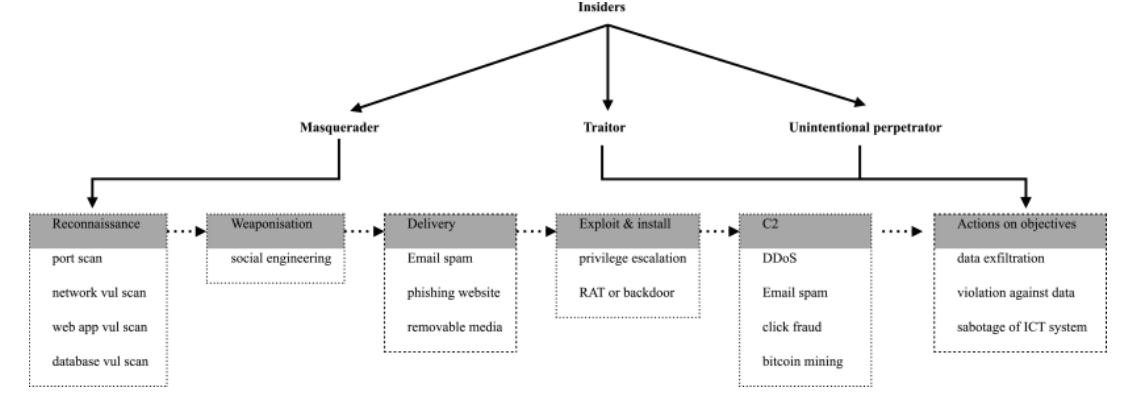
Figure 5. Insider types and methods [8] .